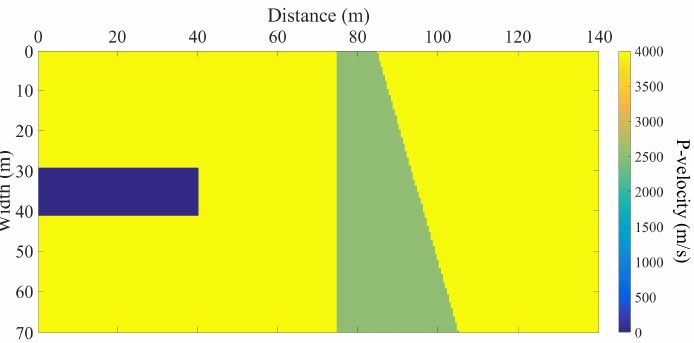
Figure 7. The model with wedge